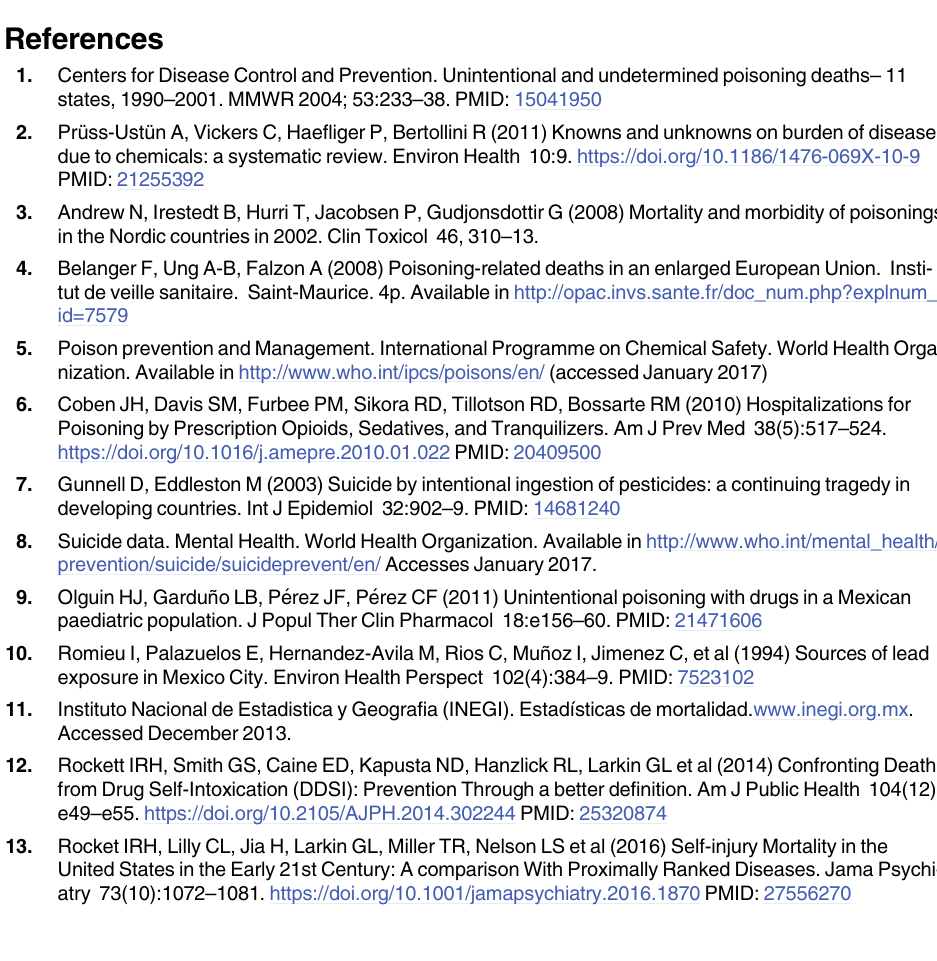
S1 Table. Raw data self poisoning Mexico. S2 Table. Raw data unintentional poisoning Mexico. S3 Table. Population Mexico 2000